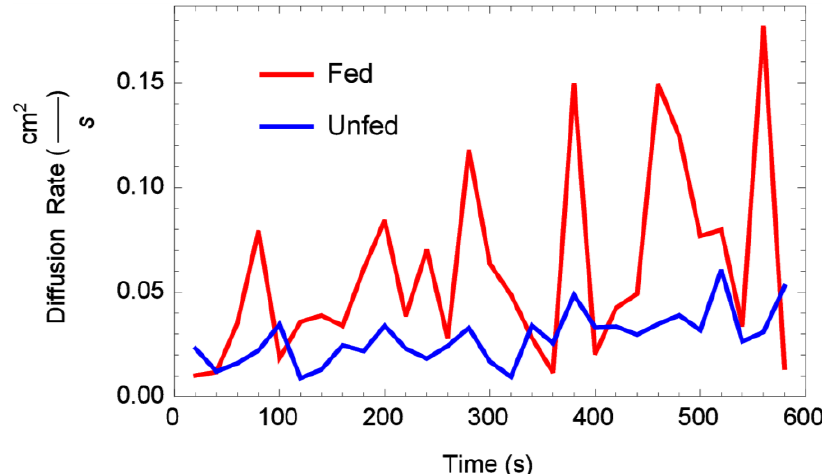
Figure 7. Estimated mean diffusion rate through time, fed vs. unfed bed bugs, one-dimensional arena.